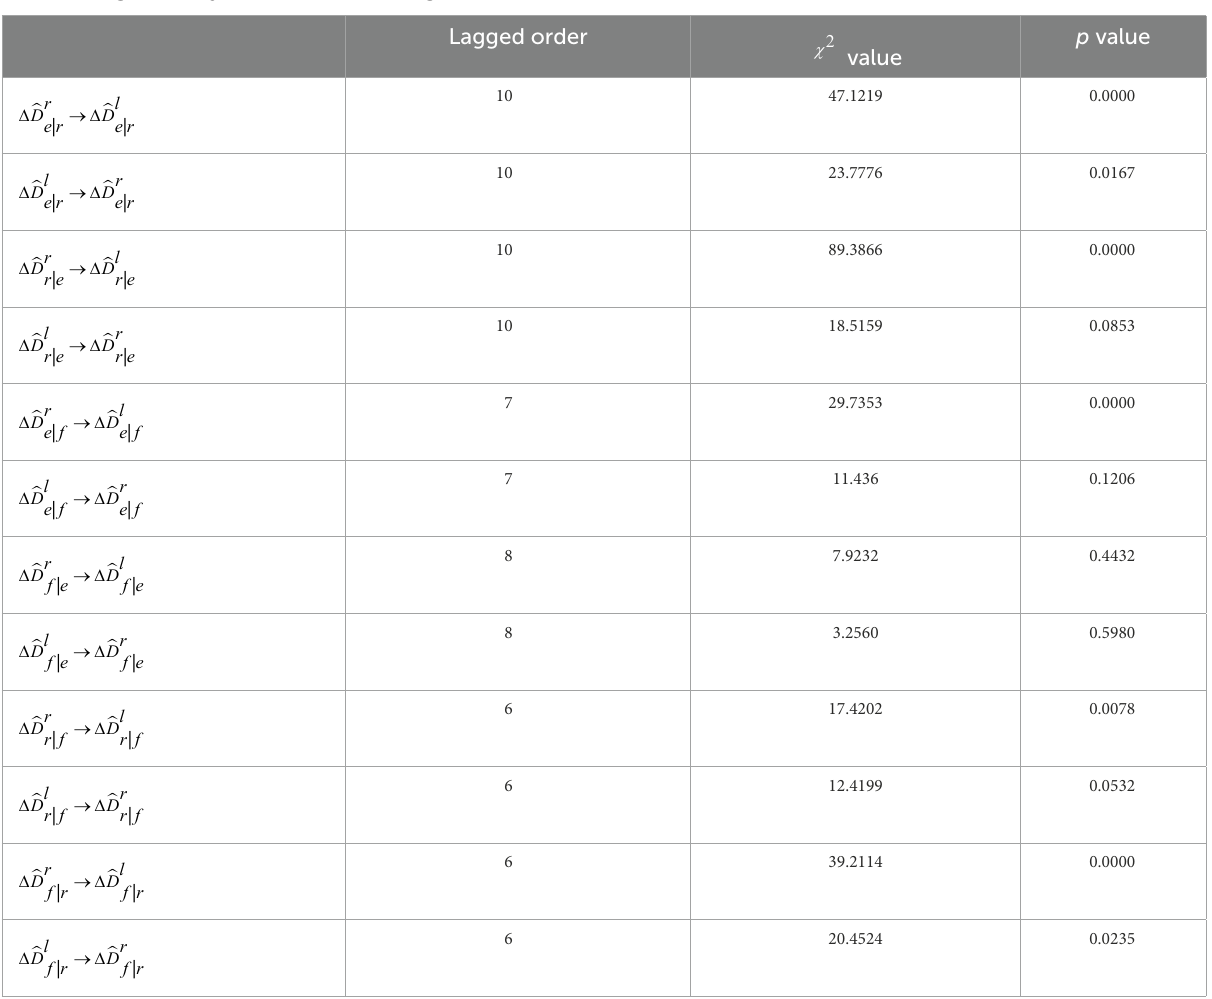
TABLE 7 Granger causality test of left-tail risk and right-tail